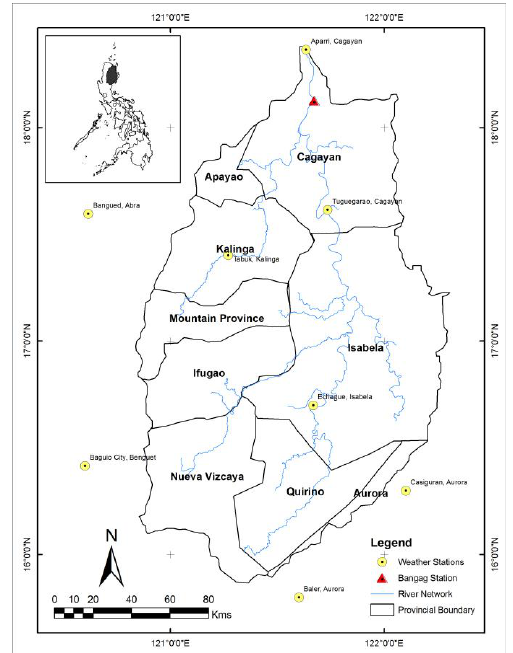
Figure 1. The Cagayan River Basin, its provinces, the Bangag Station, and weather